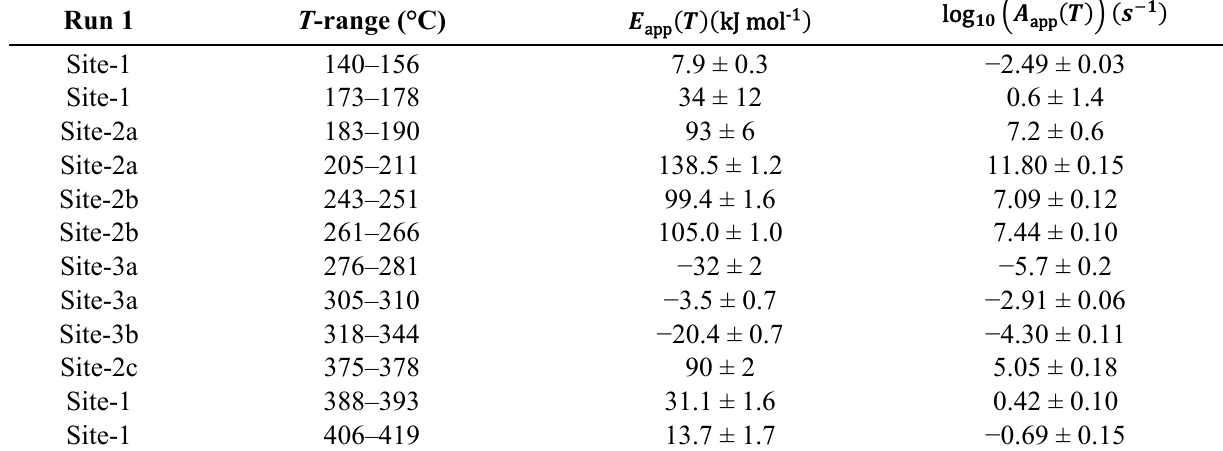
Table 1. Apparent activation energies and prefactors for each peak, plateau and shoulder plotted in Figure 1. Site-1are assigned to isobutene desorption. Site-2a, Site-2b and Site-2c